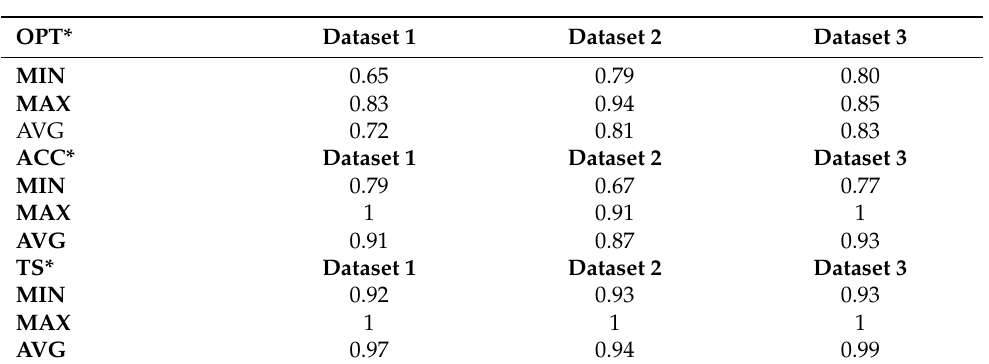
Table 3. Performance of HDPP algorithm on three data sets. We have summarized the test results of HDPP on three data sets. Each data set contains three rows of data, the first row is the minimum value, the second row is the maximum value, and the third row is the